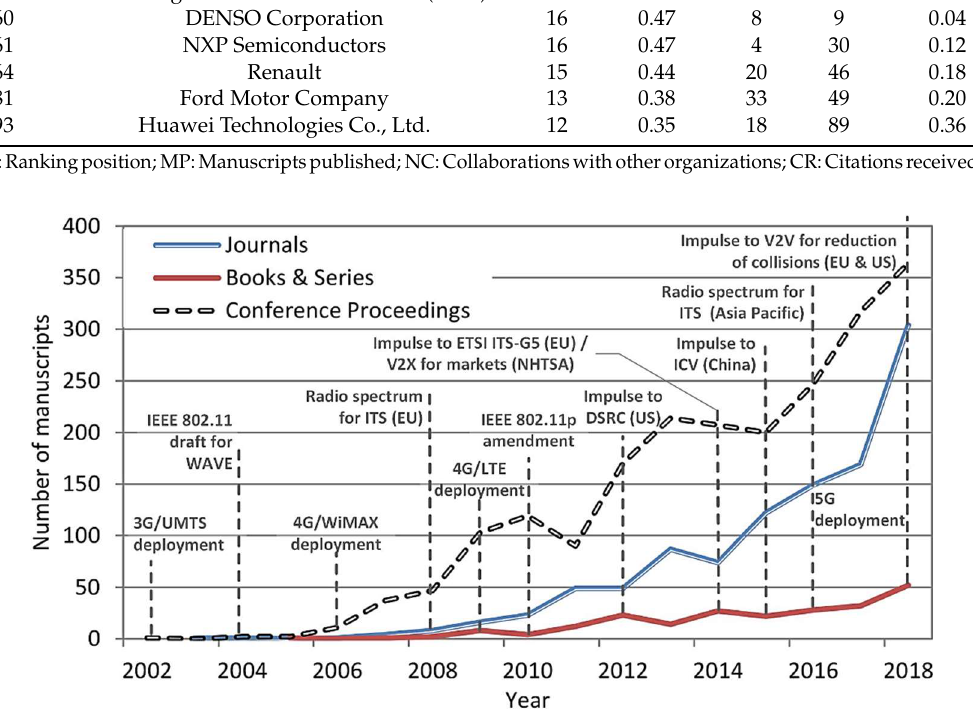
Figure 7. Bibliographic evolution of the contributions on I2X, V2X, and P2X research per source type.